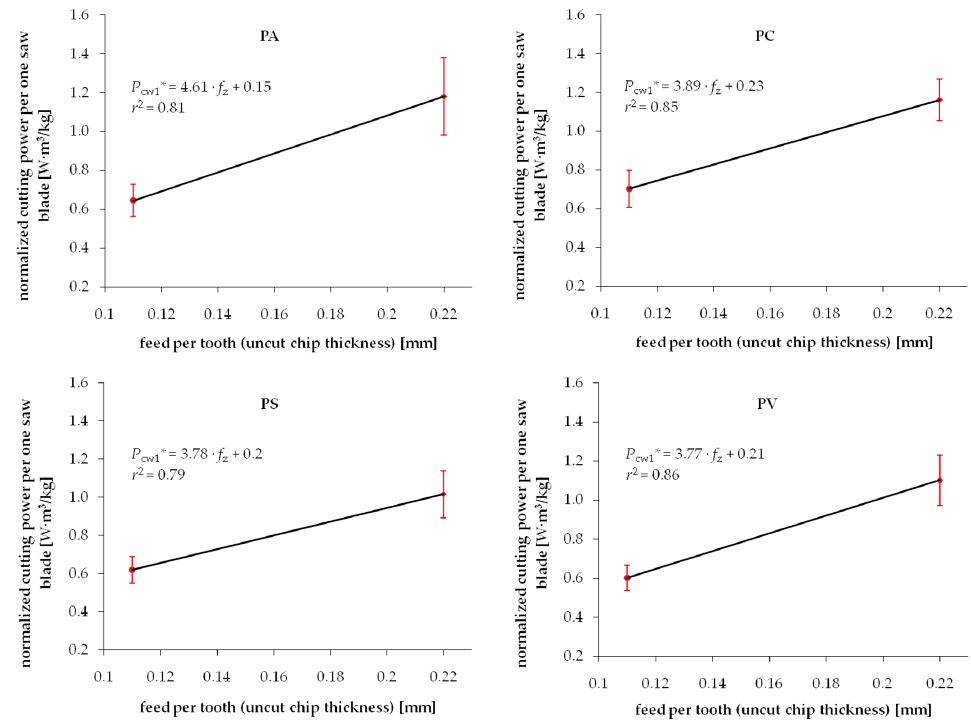
Figure 5. Relation between normalized (by density) cutting power per one saw blade and uncut chip thickness when sawing pine wood dried with different methods: PA—air drying, PC—conventional kiln drying, PS—warm heated-steam experimental drying, PV—vacuum kiln drying. Table 3. Fracture toughness R * ⊥ and shear yield stress τ * γ ⊥ normalized by density (average value and standard deviations) for of Scots pine and beech dried with different methods.